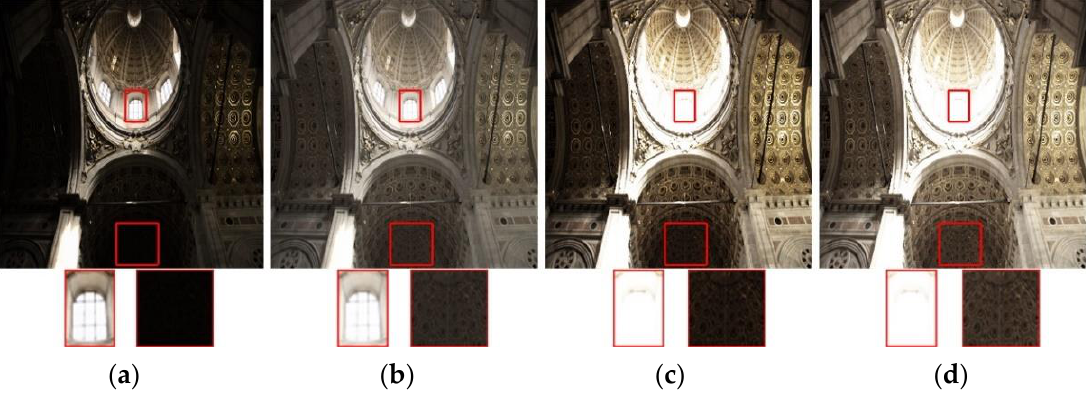
Figure 7. Enhanced results for several transformation functions. ( a ) Original image; ( b ) image enhanced by Equation (2); ( c ) image enhanced by Equation (4); ( d ) image enhanced by Equation (11).